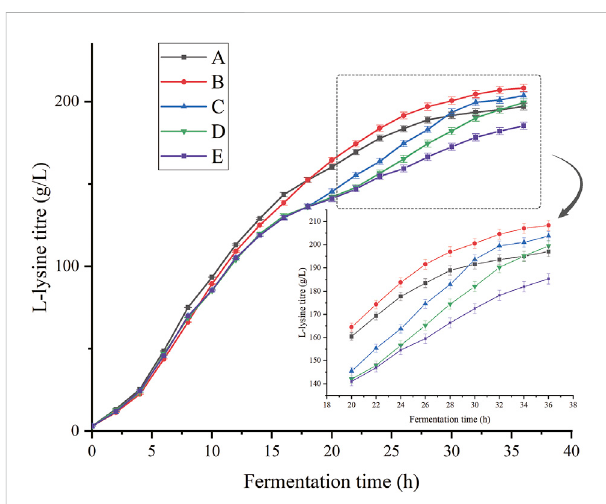
FIGURE 7 Effects of different addition times of oxygen vectors on the production of L-lysine. (A) Addition of n-dodecane from the start of fermentation. (B) Addition of n-dodecane at 8 h of fermentation. (C) Addition of n-dodecane at 16 h of fermentation. (D) Addition of n-dodecane at 24 h of fermentation (E) No n-dodecane was added to the fermentation